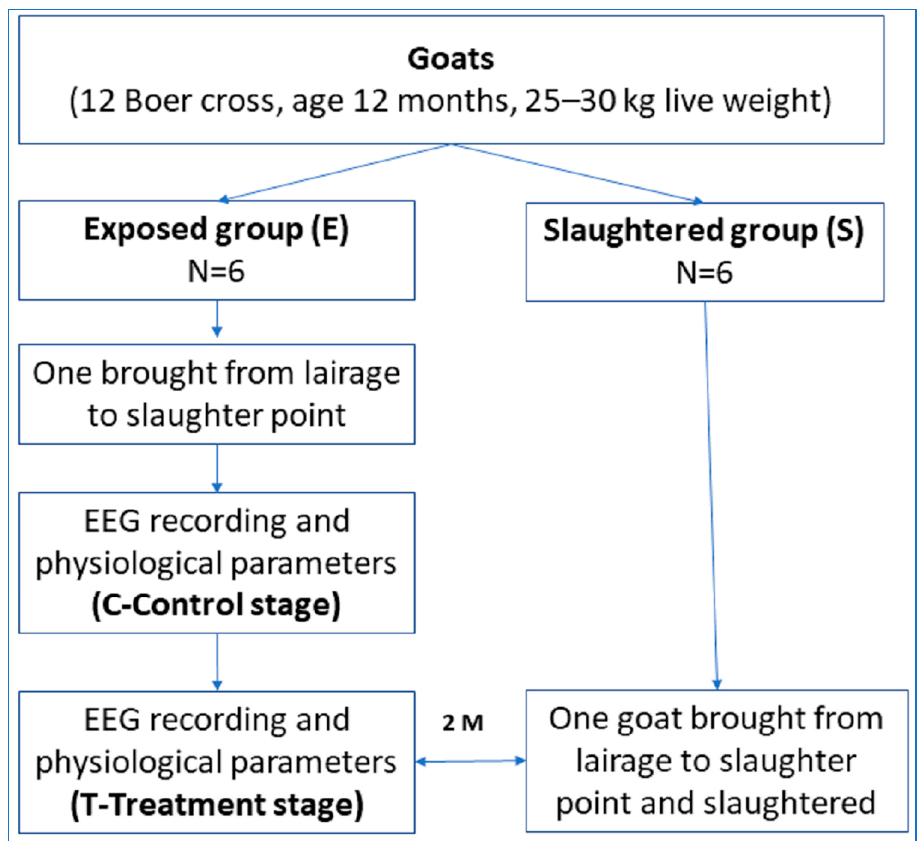
Figure 1. Experimental design of the experiment.